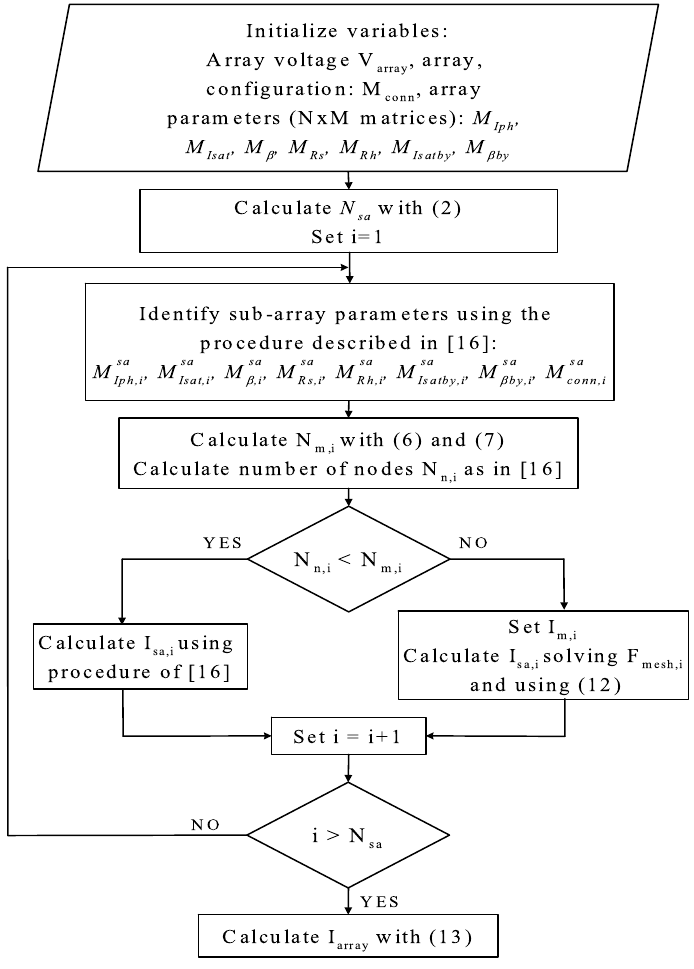
Figure 5. Flowchart of the proposed modeling approach integrated with the procedure given in